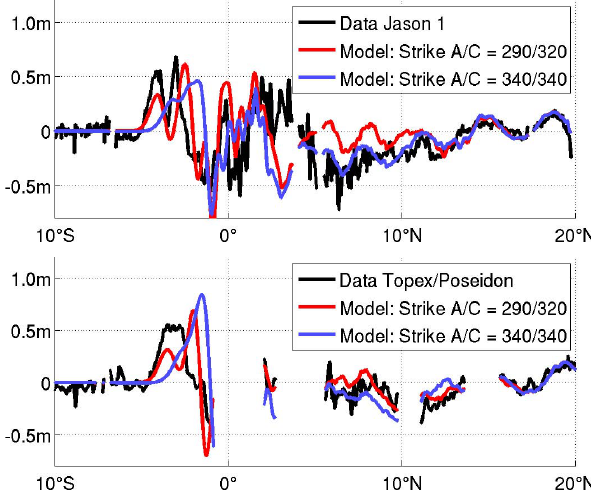
Fig. 8. Hovm¨oller diagram for the modelled sea surface elevation of the Jason 1 track (Fig. 6). The model results corresponding to the satellite observations (Fig. 7) are interpolated in space and time.